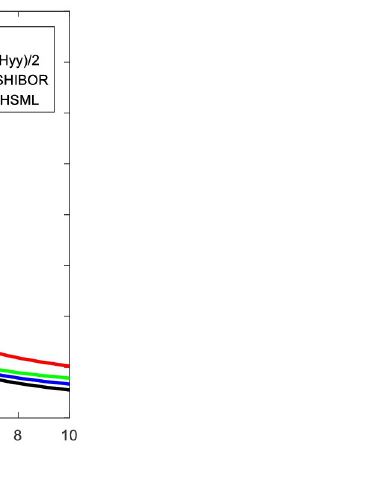
Fig 8. Short-term scaling exponent between SHIBOR and